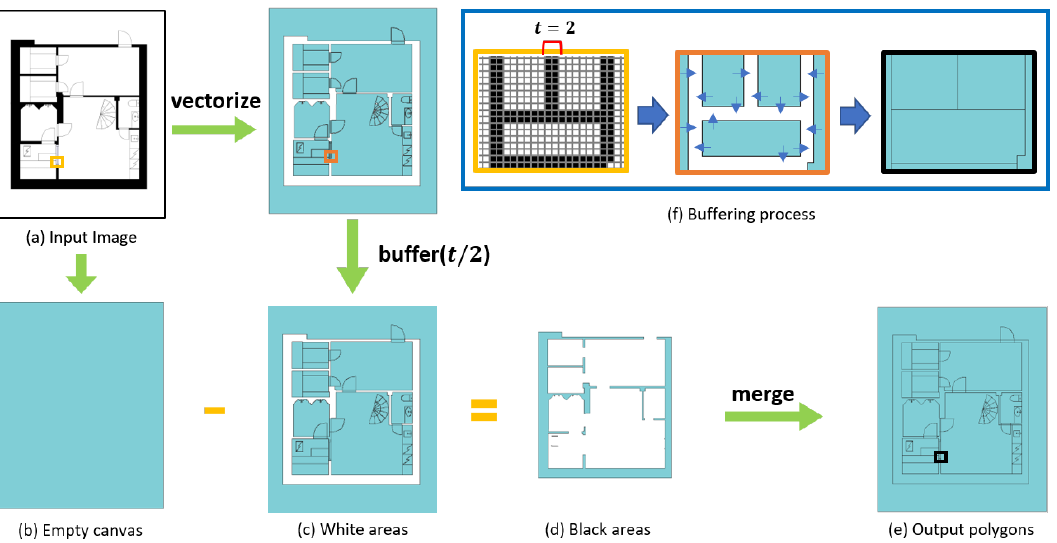
Figure 2. Overview of the vectorization process. The white areas in ( a ) are vectorized and buffered according to the thickness of the pixel lines surrounding them ( c ). The black areas are converted into polygons ( d ), which are generated by the difference operation between ( b , c ). Finally, the complete polygon set ( e ) is generated by merging the two polygon sets. ( f ) describes the detailed process of polygon buffering (the frame color of each step shows the respective small square in the process in